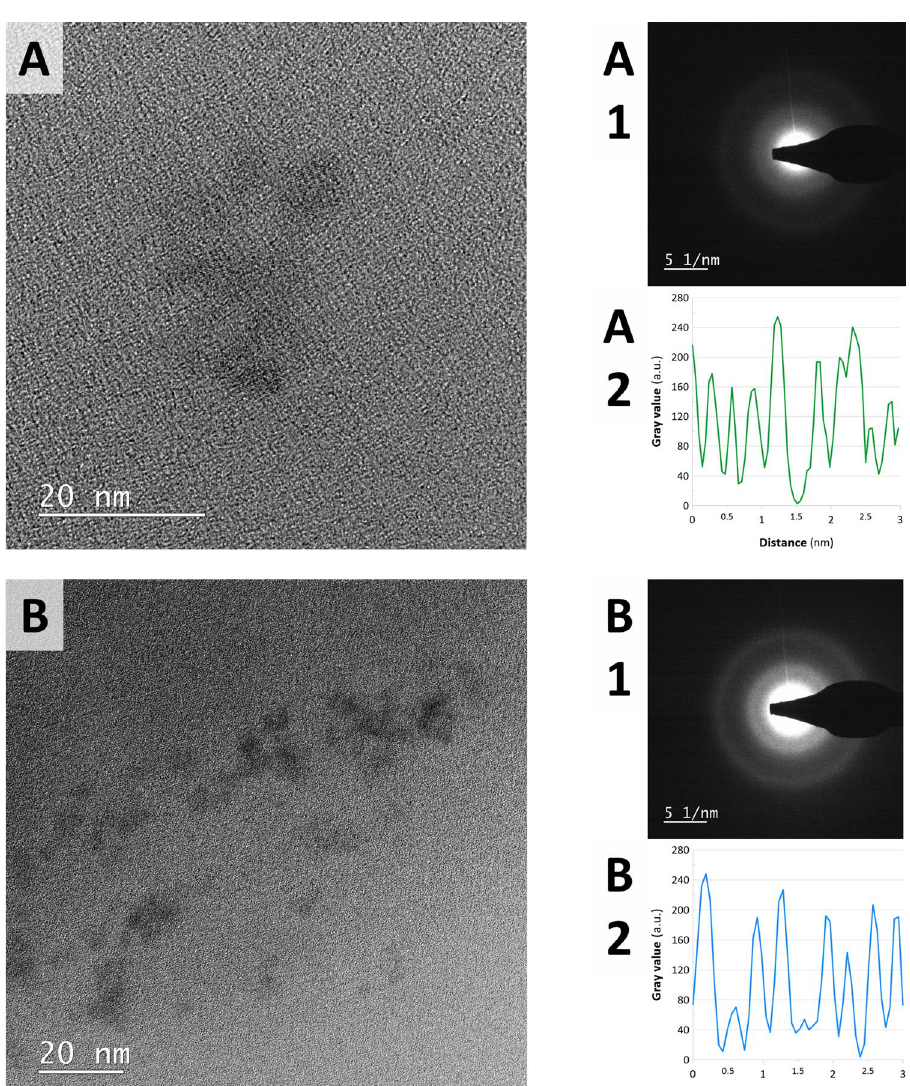
Figure 5. HRTEM photomicrographs, SAED patterns, and d-spacings profile of ( A , A1 , A2 ) Re@HEP, and ( B , B1 , B2 ) Re@CIM, The profiles displayed in panels ( A2 ) and ( B2 ) were acquired on the basis of a contrast difference in the observed planes of